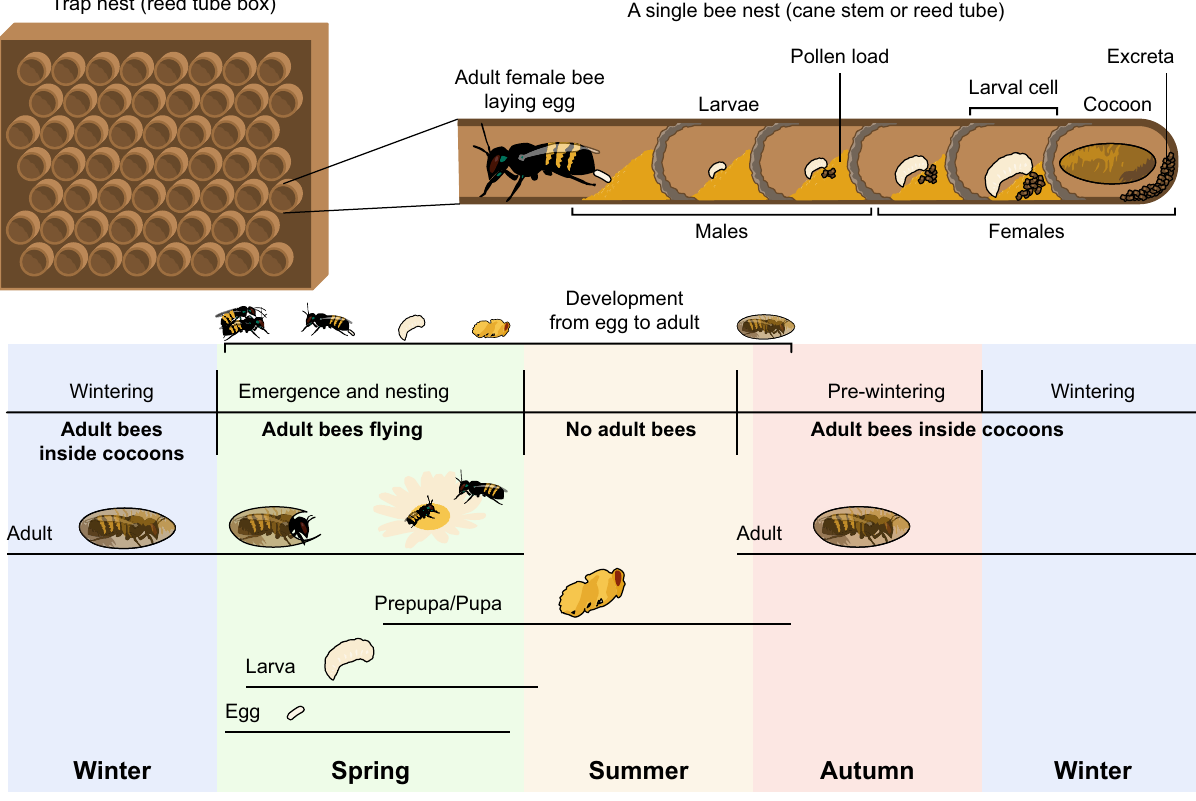
Figure 1. Nesting biology of solitary Osmia bees (applicable to various species inhabiting different continents).